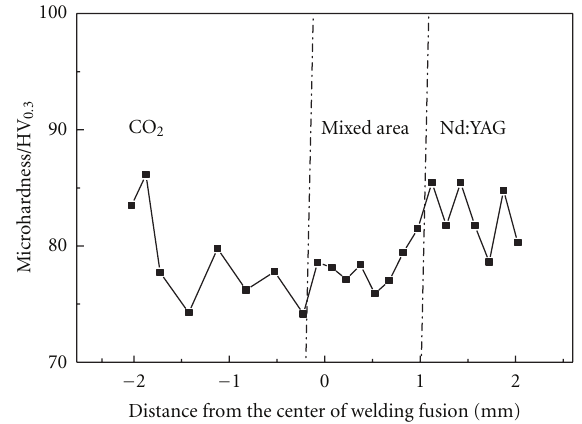
Figure 7: Microhardness of the welding seam (welding parameter: = 7 . 8KW, υ = 4m/min). P CO 2